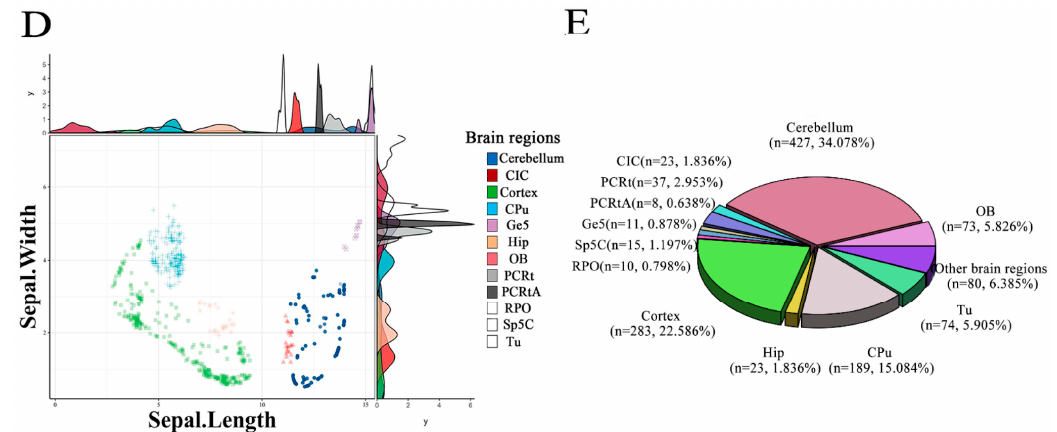
Figure 3. Distribution of tdTomato + cells in multiple brain regions of GPR158 Tag mice at P60. ( A ) Brain atlas of mice with a sagittal section (1.20 mm lateral to the midline), adapted from Paxi- nos and Franklin’s The Mouse Brain in Stereotaxic Coordinates ) [45]. ( B ) Sagittal section of the brain of a GPR158 Tag mouse (1.20 mm lateral to the midline) showing that tdTomato-tagged GPR158 was detected using immunofluorescence staining with anti-mCherry antibody. ( C ) The 13 brain regions with relatively high densities of tdTomato + cells in the GPR158 Tag mouse brain sagittal section shown in panel B, annotated using Imaris software. ( D ) Dot plot combined with density plot showing the distribution and density of tdTomato + cells in each of the 13 brain regions. ( E ) 3D pie chart showing the percentage distribution of tdTomato+ cells in 13 brain regions (OB, olfactory bulb; cortex; Hip, hippocampus; CPu, caudate putamen; Tu, olfactory tubercle; CIC, central nucleus of the inferior colliculus; cerebellum; RPO, rostral periolivery region; PCRt, parvicellular reticular nucleus; PCRtA, parvicellular reticular nucleus, alpha part; Sp5, spinal trigeminal nucleus; Sp5C, spinal trigeminal nucleus, caudal part; Ge5, gelatinous layer of the caudal spinal trigeminal nucleus). Scale bars, 1000 µ